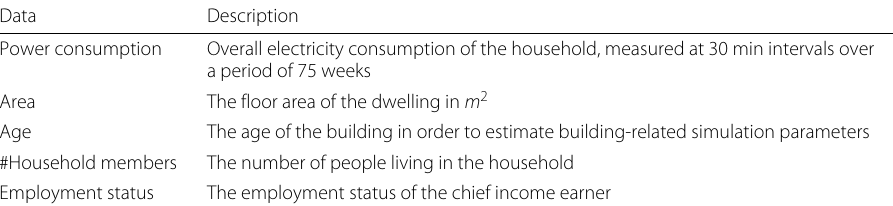
Table 1 The data from the CER dataset relevant for our savings